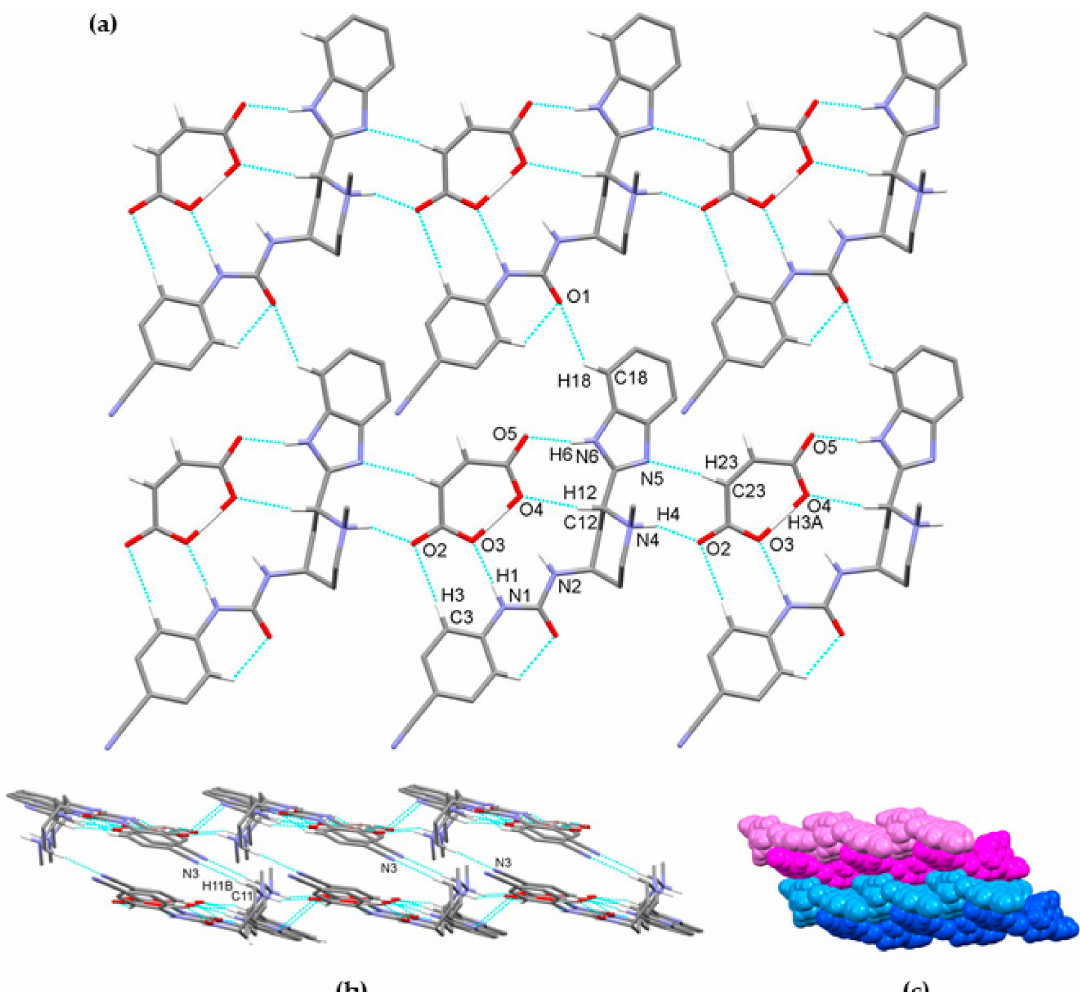
Figure 11. Hydrogen-bond architecture in the glasdegib monomaleate: ( a ) layer formation along bc plane; ( b ) formation of double layers via C11–H11b · · · N3 interactions; ( c ) packing of double layers along a axis (arbitrary colors; one double layer is presented by light and dark blue and second double layer is represented by light and dark magenta). Hydrogen bonds are represented by dashed blue lines. Hydrogen atoms not involved in the motif shown have been omitted for